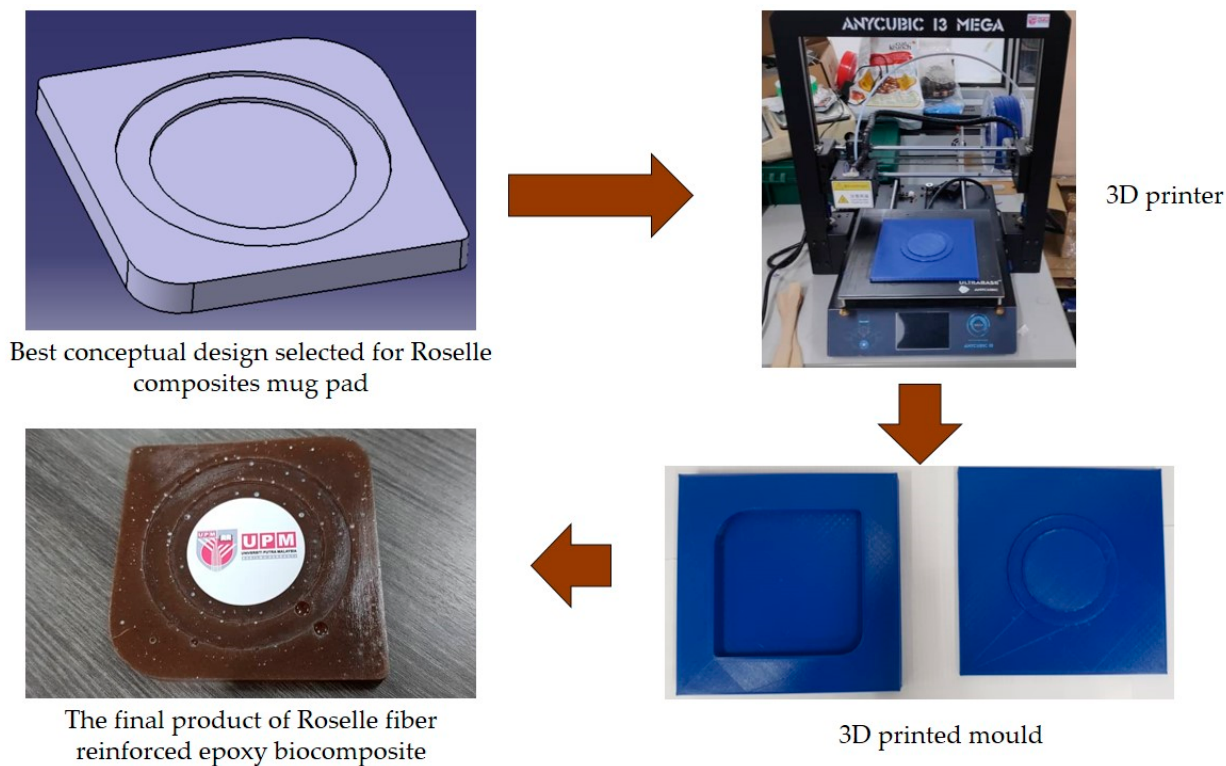
Figure 7. Mug pad holder using roselle fiber-reinforced polymer composites.